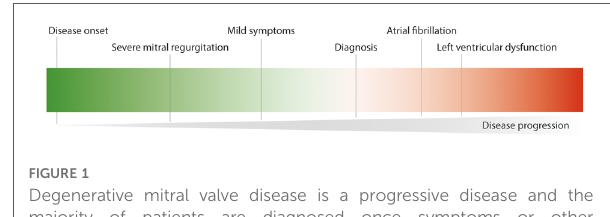
FIGURE 1 Degenerative mitral valve disease is a progressive disease and the majority of patients are diagnosed once symptoms or other complications